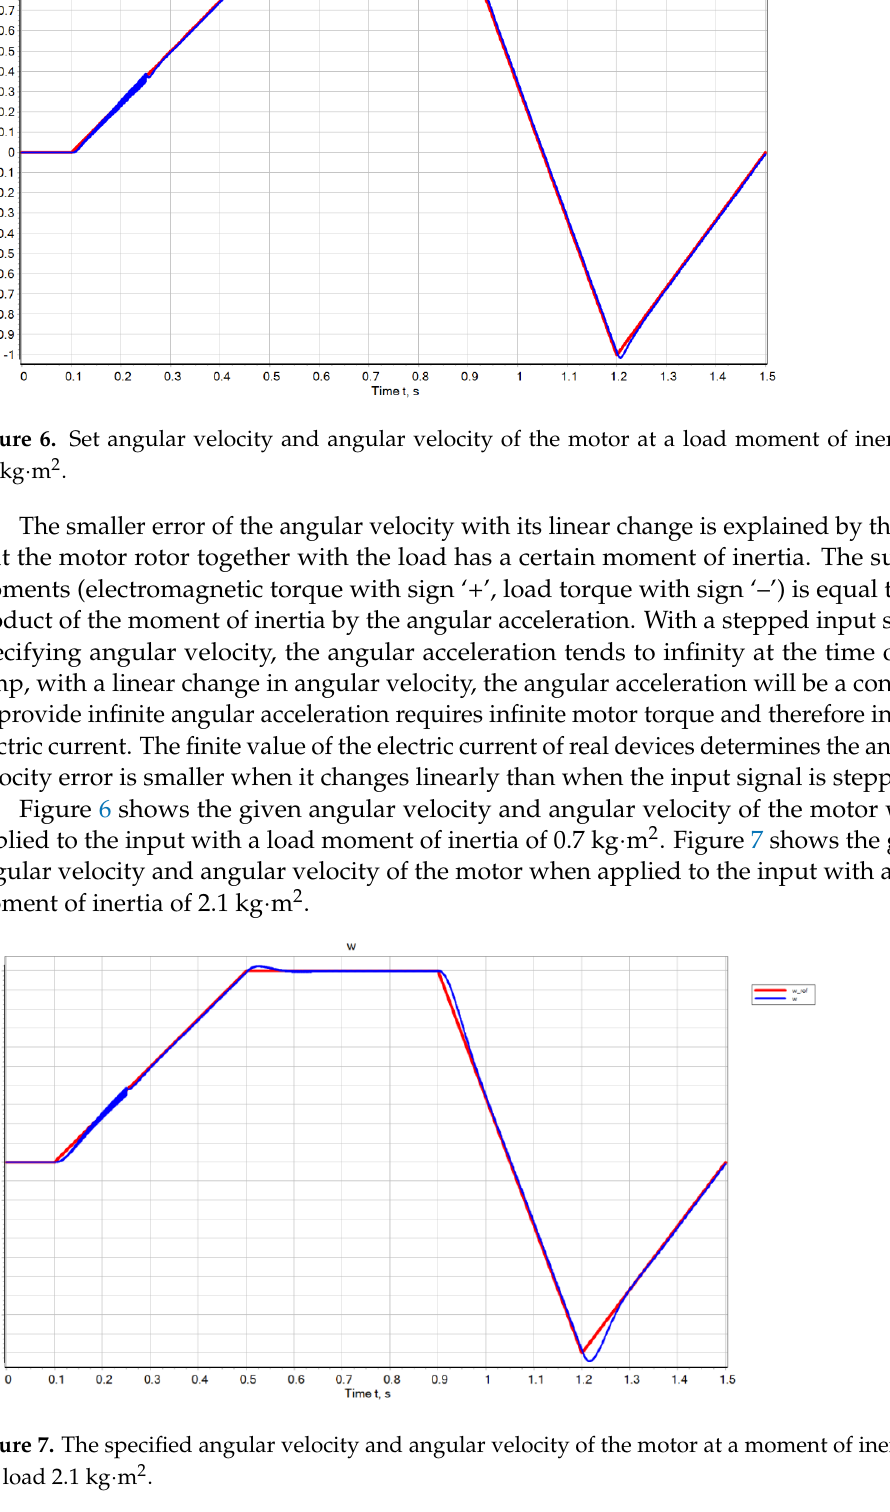
Figure 8. Mockup of the motor. The stator is assembled from individual coils in 5 groups, each group is connected to one of the power supply phases, the phases are connected in a “star” pattern (Figure 9).